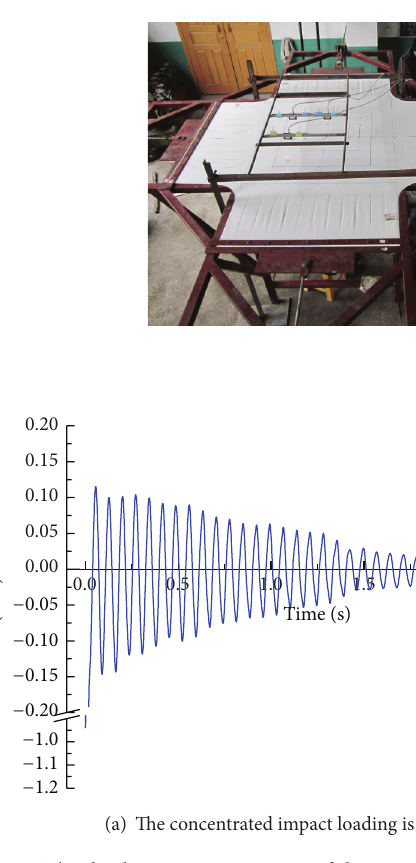
Figure 7: The displacement-time curve of the C1 point for square Heytex membrane under the concentrated impact loading ( 𝐹 0𝑥 = 𝐹 0𝑦 = 1 kN).